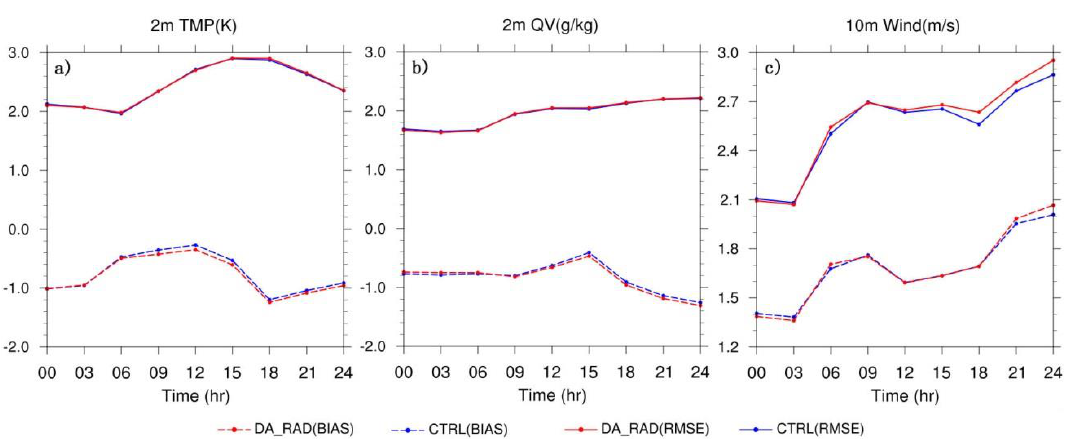
Figure 8. The average errors (bias score (BIAS)) and RMSEs of forecasting ( a ) temperature (TMP) at 2 m, ( b ) humidity (QV: QVAPOR) at 2 m, and ( c ) wind at 10 m over the forecast range of 0–24 h for CTRL and DA_RAD.